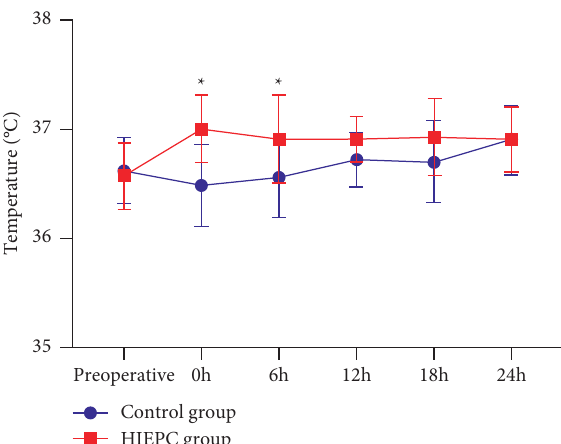
Figure 1: Changes in body temperature of the two groups of patients: temperature measurements at 0h and 6 h after the operation showed that the body temperature of the HIPEC group was higher than that of the control group ( P < 0 . 05). There was no difference in body temperature between the two groups at 12, 18, and 24 hours after operation ( P > 0 . 05).